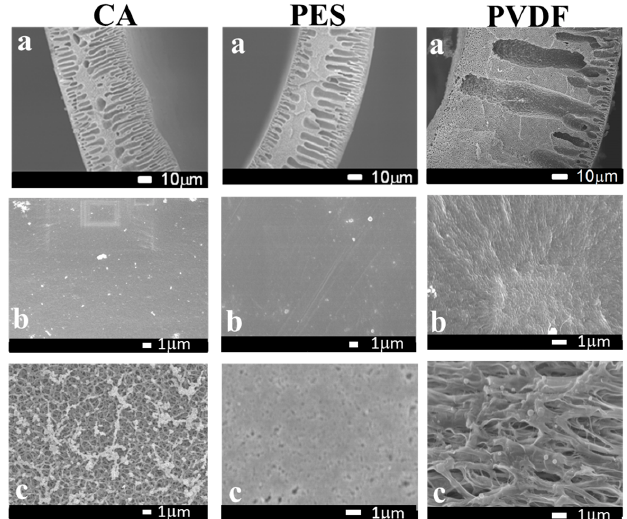
Figure 2. SEM images of cellulose acetate (CA) (30 nm), polyethersulfone (PES) (30 nm), and polyvinylidene fluoride (PVDF) (20 nm) hollow fiber ultrafiltration membranes: ( a ) cross ‐ sections; ( b ) outer surfaces; ( c ) inner surfaces.